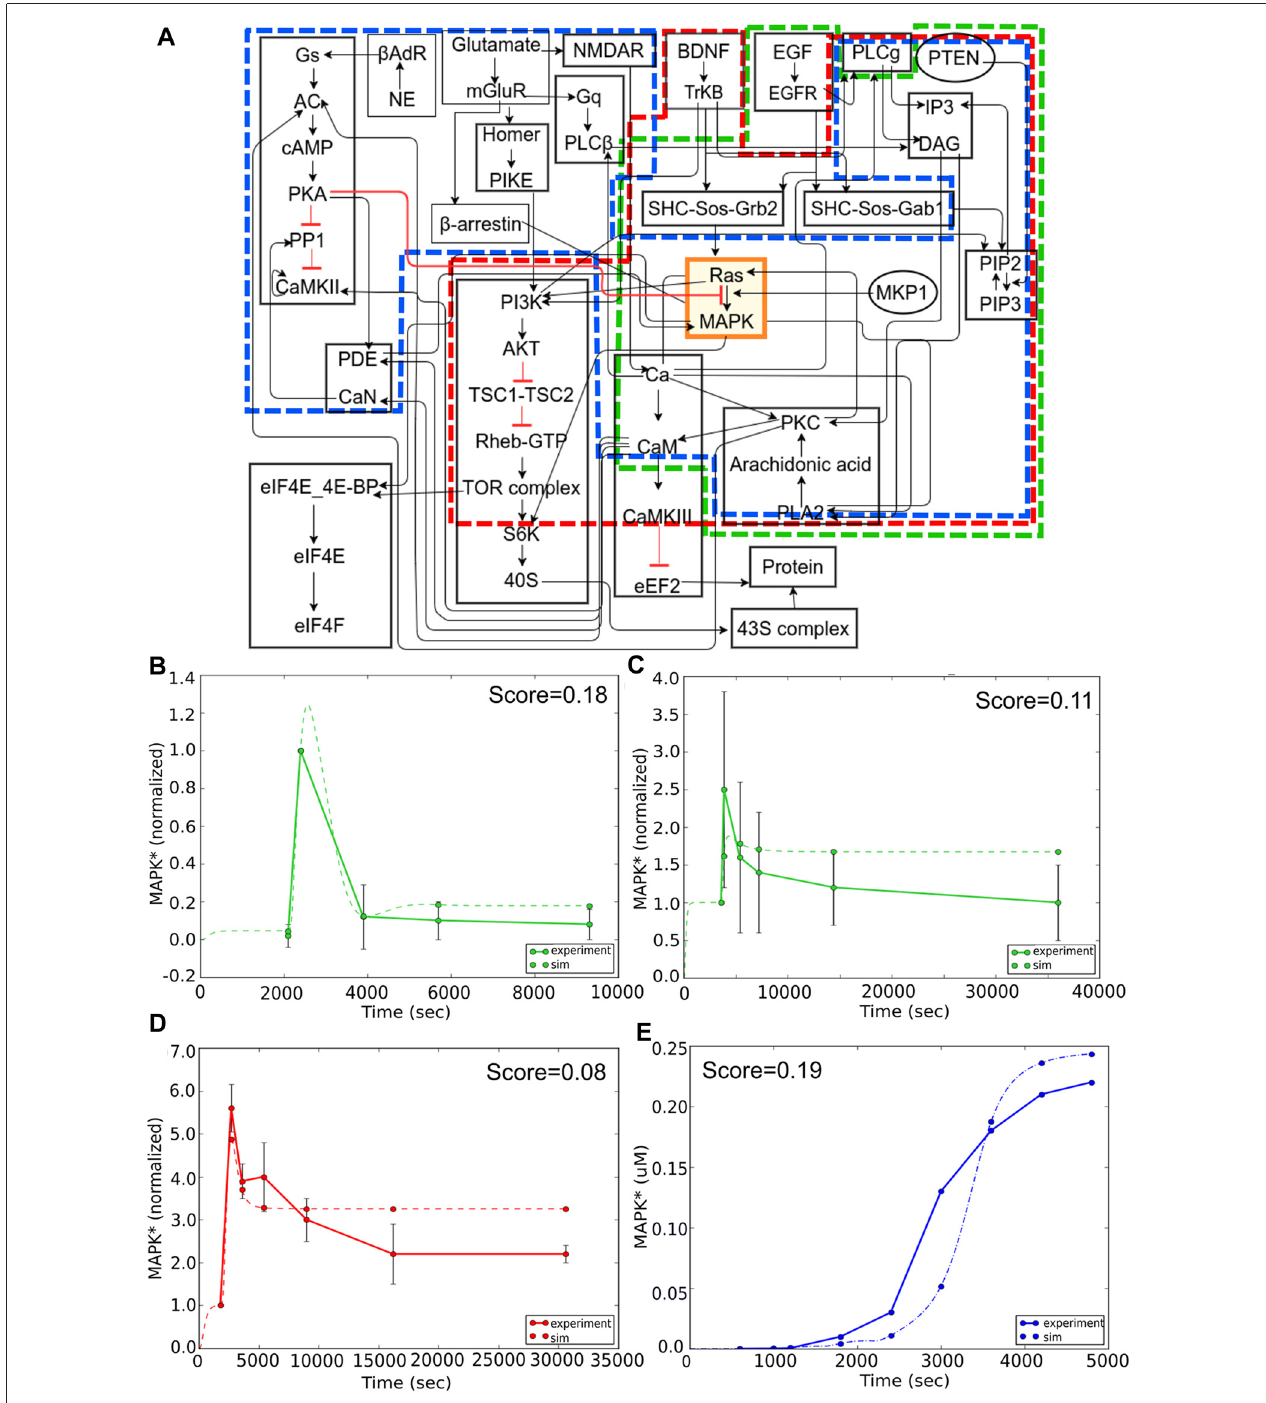
FIGURE 7 | Reproducibility example: multiple experimental inputs converging onto a common signaling pathway (MAPK). (A) Block diagram of composite model. Sub-models for the different inputs are indicated in green (epidermal growth factor, EGF), red (BDNF) and blue (Calcium). (B) Response to EGF stimulus is a transient activation of MAPK. Model (dashed green line) closely follows experimental curve (solid green line). (C) Response to EGF in similar preparation but lower dose. Note that the simulated peak response is higher than experiment in (B) , but lower in (C) , leading to difficulties in model fitting. (D) Response to BDNF stimulus is also a transient, but the time-course of MAPK signaling in this experiment is much longer than it was in panel (B) . (E) Response to an LTP-induction stimulus for calcium, consisting of three pulses separated by 600 s. Here the reference is an earlier simulation predicting sustained activation of MAPK. Remarkably, there is a reasonable match to the reference behavior in all three cases, despite the inputs converging onto the MAPK pathway through different signaling pathways, and the results drawn from very different data sources.